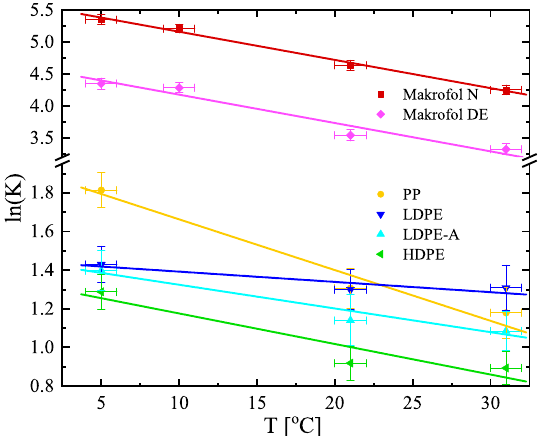
Figure 6. Temperature dependence of the partition coefficients of the studied materials. Note that the dependence is ln( K ) vs. T . The points are the experimental data and the solid lines are linear fits of the data. The uncertainties are at the level of 1 σ .